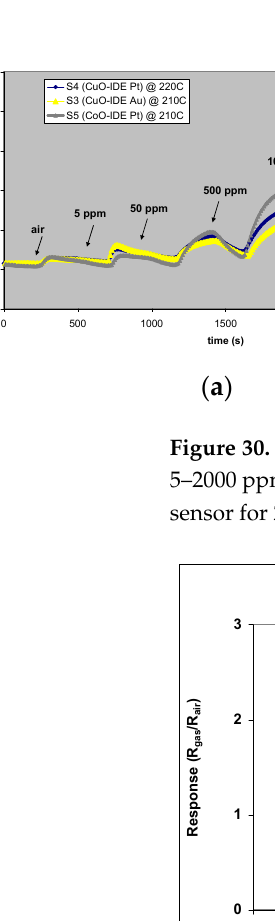
Figure 29. SEM images of ( a ) CoO sensitive film; ( b ) CuO sensitive film, at different magnification factors; last two images of each group ( a , b ) are tilted at a specific angle, from ref. [155]. The sensitive films may be characterized as thin, having sub-micron thickness, but they are no longer transparent, as it can be seen in the actual photo of a sensor sample from Figure 28b (the sensitive film is visible as a dark-grey coating in the IDE area). As before, the experimental targets were set to obtain high 3S parameters for the tested sensor samples. The sensor’s response for CH 4 , RH (52%), and CO 2 was evaluated and acquired as electrical resistance values (denoted as R s ), directly from the measure- ment equipment (RLC bridge). It was observed that the IDE material does not influence gas sensing performance (when comparing gold with platinum, chosen for their superior conductivity character-